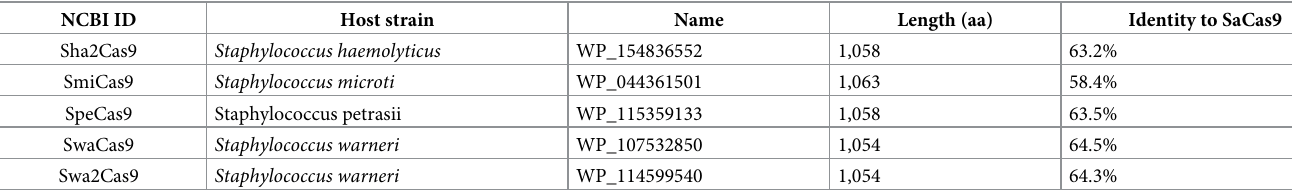
Table 1. Five SaCas9 orthologs selected from the NCBI